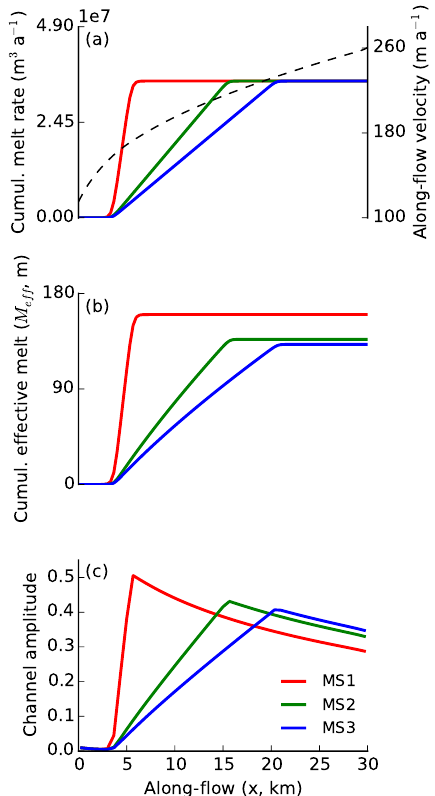
Figure 3. Colored curves display the along-flow cumulative melt rates for the different melt scenarios (MS1–3, Table 1) in (a) , the ef- fective melt in (b) and the corresponding channel amplitudes in (c) for a laterally unconstrained ice shelf in steady